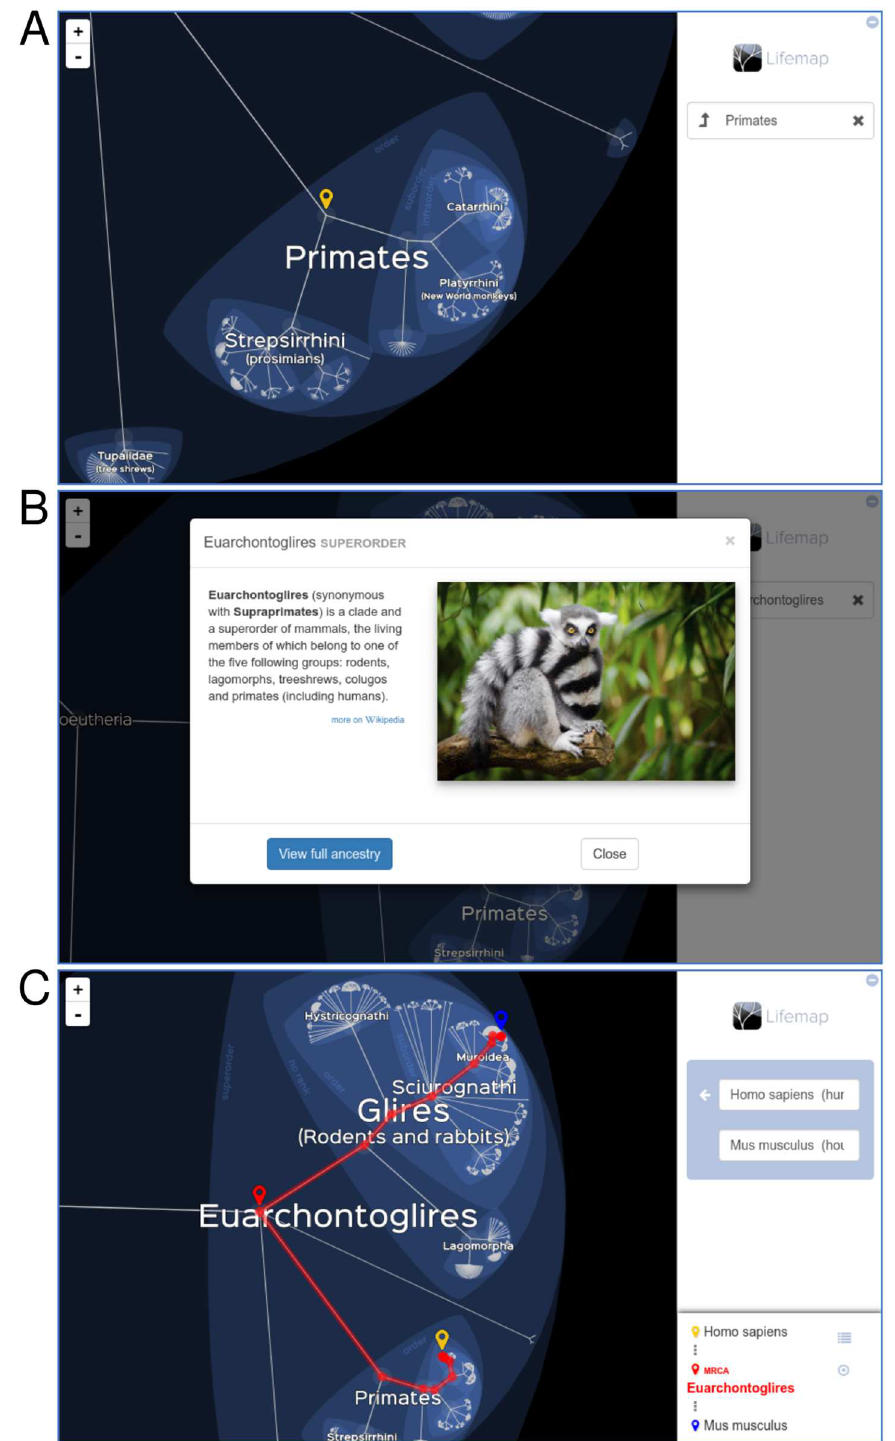
Fig 2. Screenshots of the Lifemap tool. ( A ) Exampleof the appearance of Lifemap when zoomingto the primates order. ( B ) Exampleof information displayedin the generalpublic versionwhen clickingon a node. ( C ) Visualization of the path betweentwo taxa. Lemur image credit: MathiasAppel, Flickr (https://flic.kr/p/ FKtBbU).